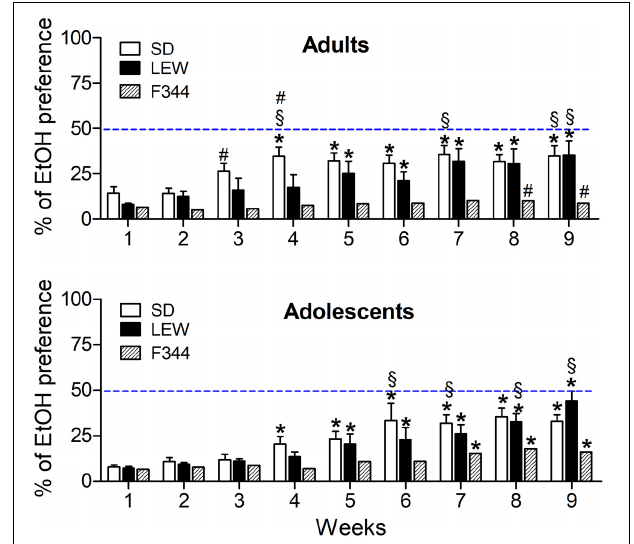
FIGURE 3 | Cumulative ethanol and water intake in 9 weeks. (A) Total ethanol intake (g/kg/9 weeks) in adult and adolescent groups of the three strains. Data are expressed as means ± SEM. * p < 0.05 Sprague-Dawley (SD) vs. Lewis (LEW), §§ p < 0.001 SD vs. Fischer 344 (F344), § p < 0.05 LEW vs. F344, ** p < 0.01 F344 adolescents vs. adults by one-way ANOVA followed by Tukey’s post hoc test. (B) Cumulative water intake (g/kg/9 weeks) in adult and adolescent groups of the three strains. Water intake by control rats (CT) is reported for comparison with ethanol-exposed rats (EtOH). * p < 0.05 LEW CT vs. SD and F344 CT; ** p < 0.001 LEW EtOH vs. SD and F344 EtOH by two-way ANOVA followed by Tukey’s post hoc test.